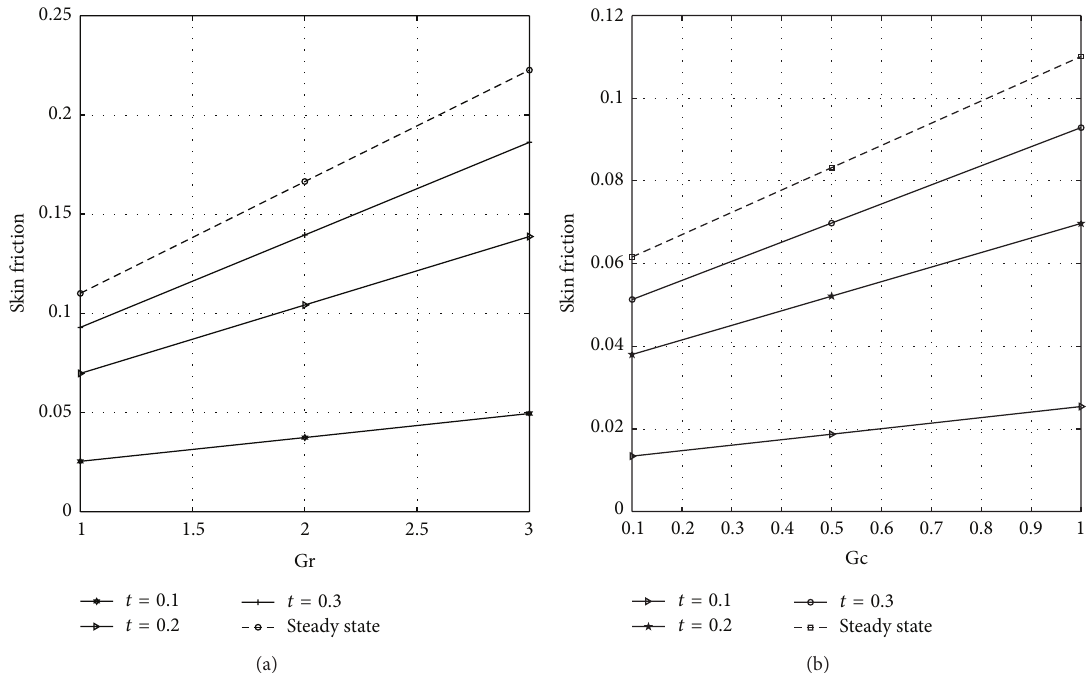
Figure 14: Variation of skin friction with Gr and Gc with time ( 𝑡 ) at 𝑦 = 1